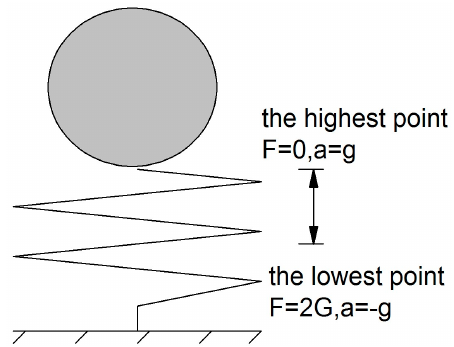
Figure 12. A weight with no velocity is placed above a spring suddenly.